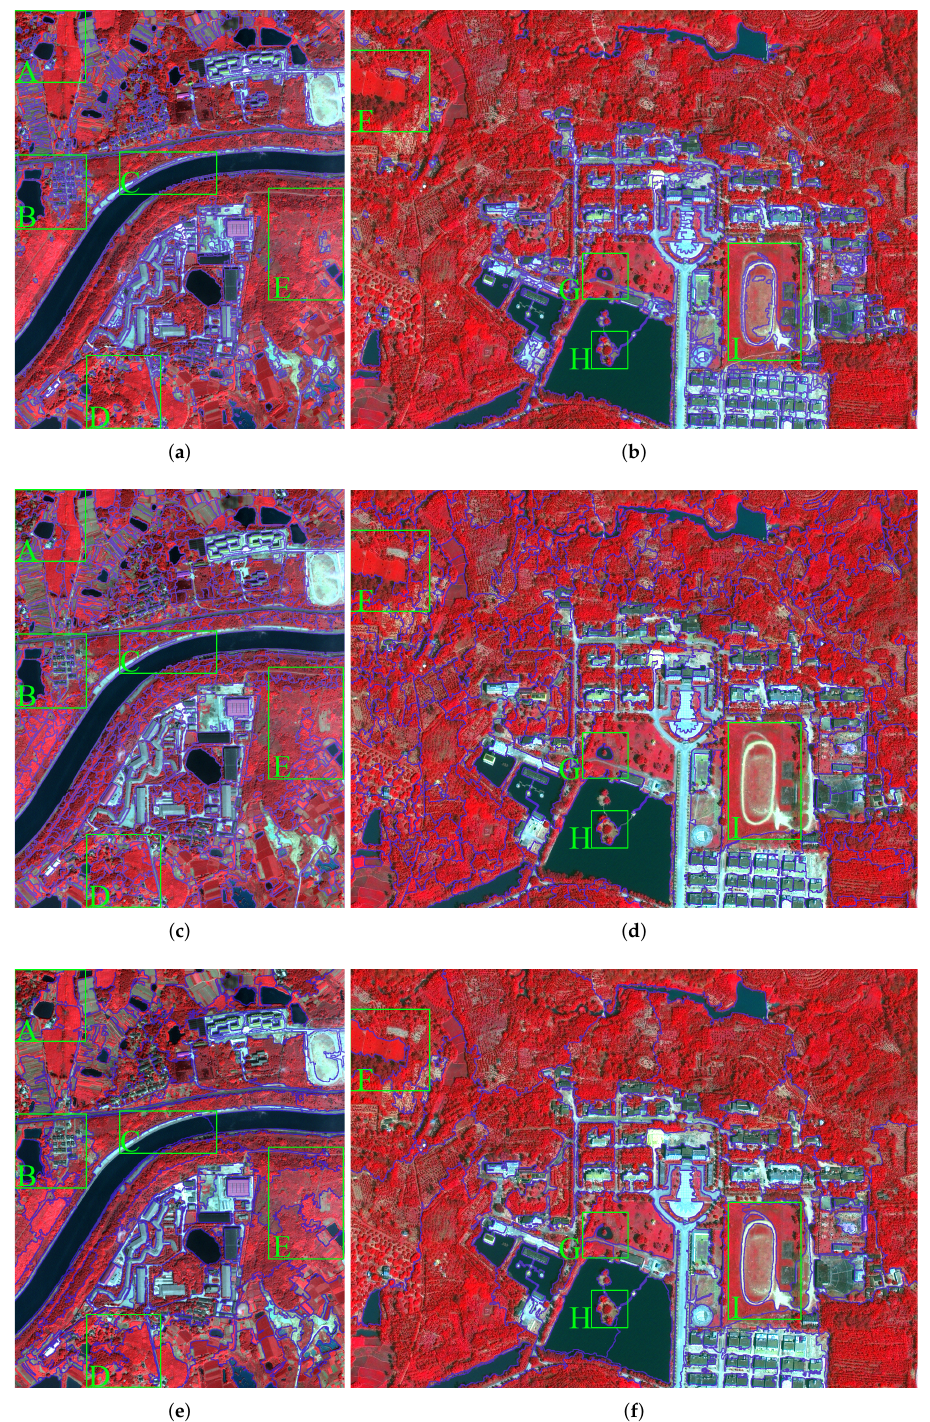
Figure 15. The optimal segmentation result of datasets D1 and D2 based on the SI-marker method, the Hill-marker watershed segmentation method, and the MRS method. ( a ) SI-marker method; scale = 10; ( b ) SI-marker method; scale = 20; ( c ) Hill-marker method; scale = 60; ( d ) Hill-marker method; scale = 300; ( e ) MRS method; scale = 200; shape = 0.2; ( f ) MRS method; scale = 400; shape =